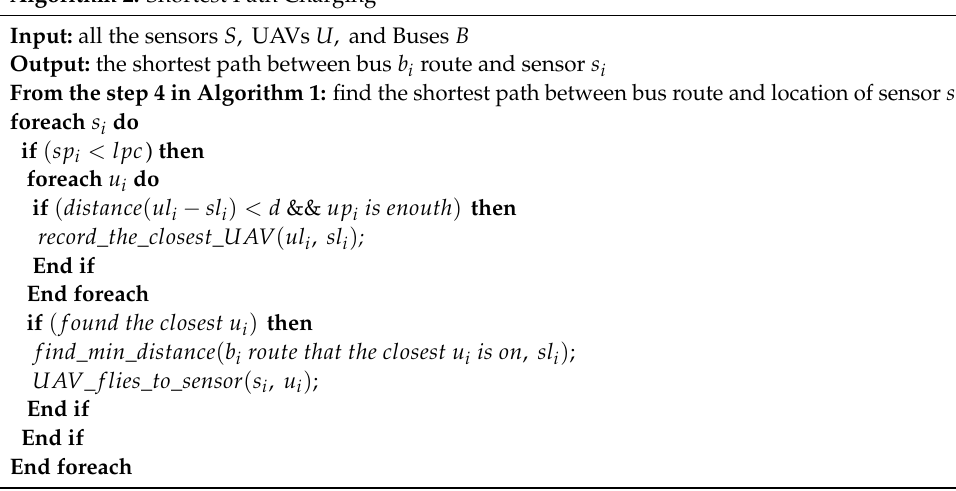
Algorithm 2: Shortest Path Charging